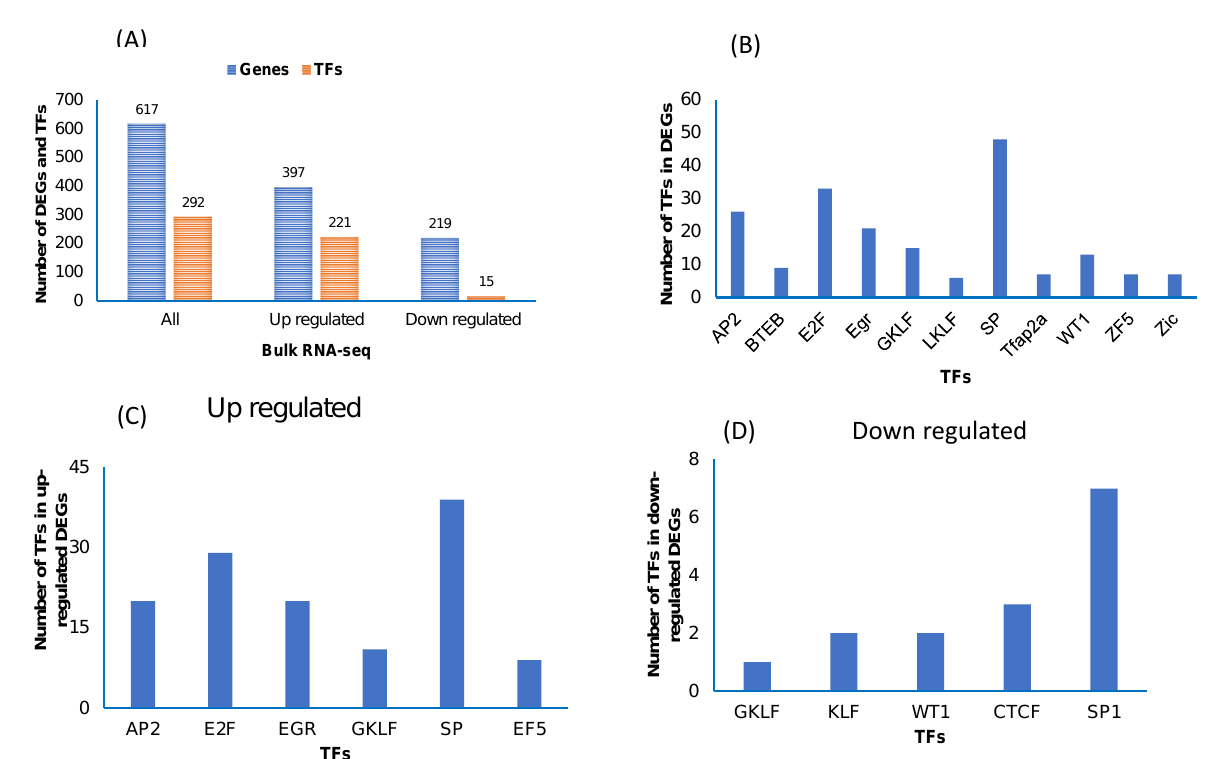
Figure 6. Transcription factors (TFs) in vWAT of the differentially expressed genes (DEGs) in mice exposed to RA and IH in individual cell types and in all cell types combined. ( A ) TFs for the DEGs for each cell type. ( B ) The major TFs identified for all cell types and adipocytes that were found in adipocyte cell types (clusters 4 and 8). ( C ) The major TFs were identified in the up regulated genes. ( D ) The major TFs were identified in the down regulated